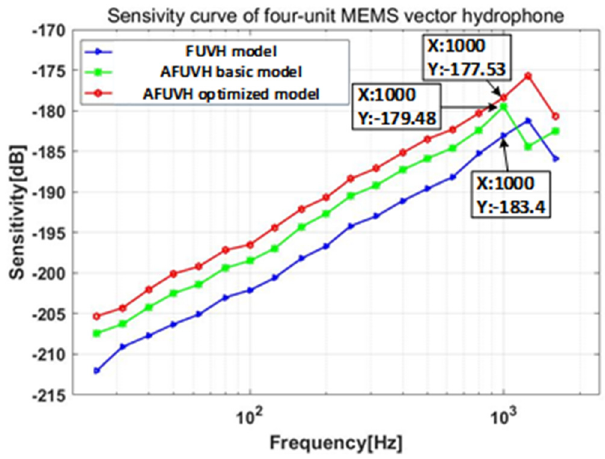
Fig. 19. Sensitivity curve of